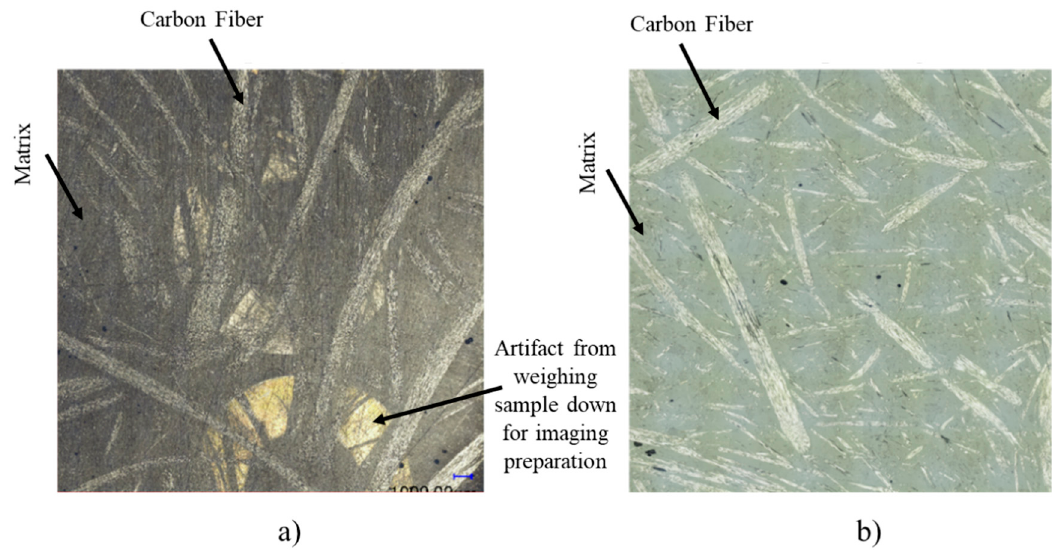
Figure 3. Polished samples showing the microstructure obtained in composite; ( a ) Micrographs for samples obtained by Method 1, and ( b ) Micrographs for samples obtained by Method 2.